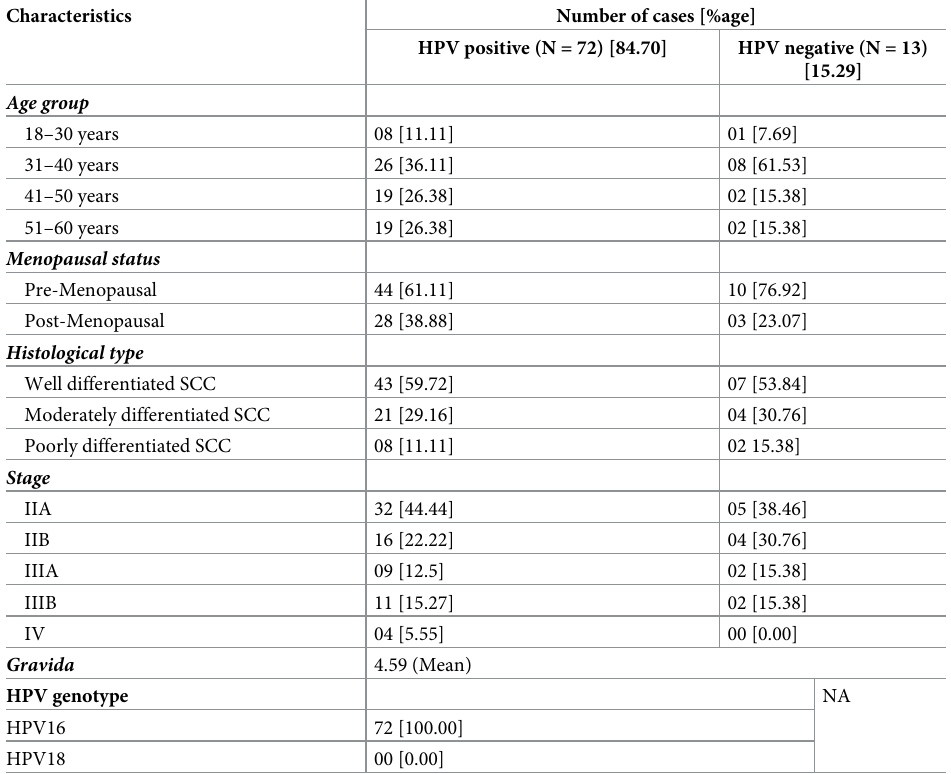
Table 2. Demographical and clinico-pathological profile of cervical cancer subjects in the study.